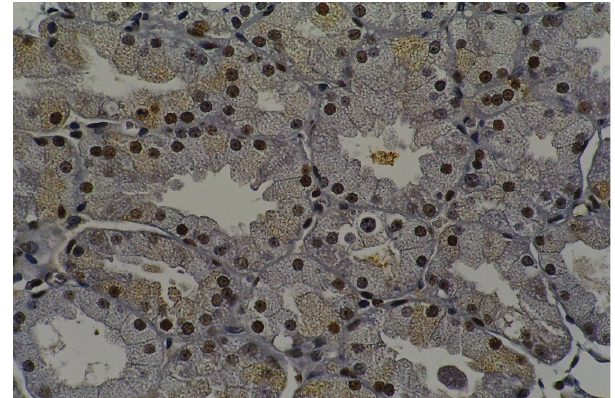
Figure 1 - Rat parotid gland with normal parenchyma. Immunohistochemical staining of PCNA on epithelial cells (C60, original magnification 400X).